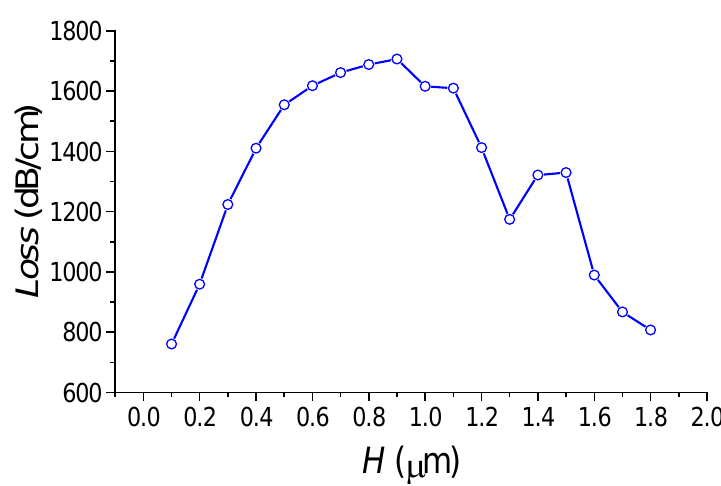
Figure 14. Dependence of the propagation loss in segmented grating obtained as the transmitting power of the Gaussian optical beam launched into polymer strip connected with segmented grating of different height H . M = 256, M = 128, W = 1.0 µm, h = 0.25 µm, w = 0.45 µm, d = 0.1 µm. The simulation by 2D FDTD.